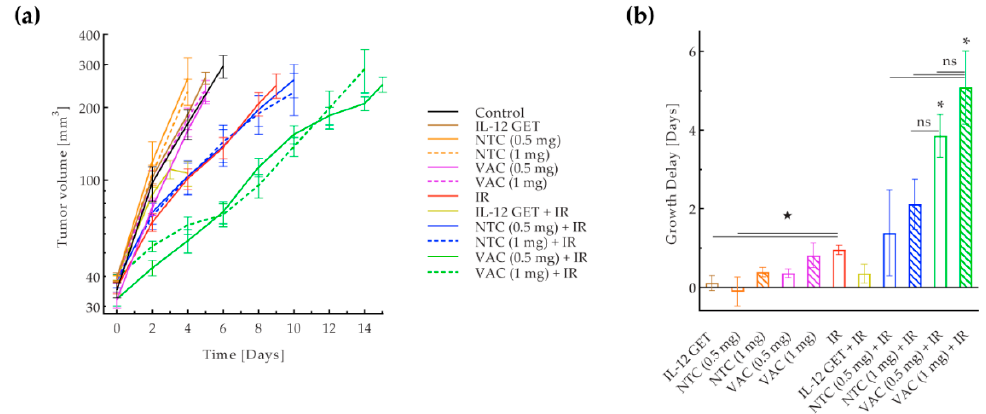
Figure 4. Adjusted B16 ‐ F10 vaccination. ( a ) Tumor growth curve. Tumor volume in a logarithmic scale plotted against time. ( b ) Tumor growth delay based on the tumor doubling time. Seven treatment groups with 6–12 mice were included in the experiments. The control group received a